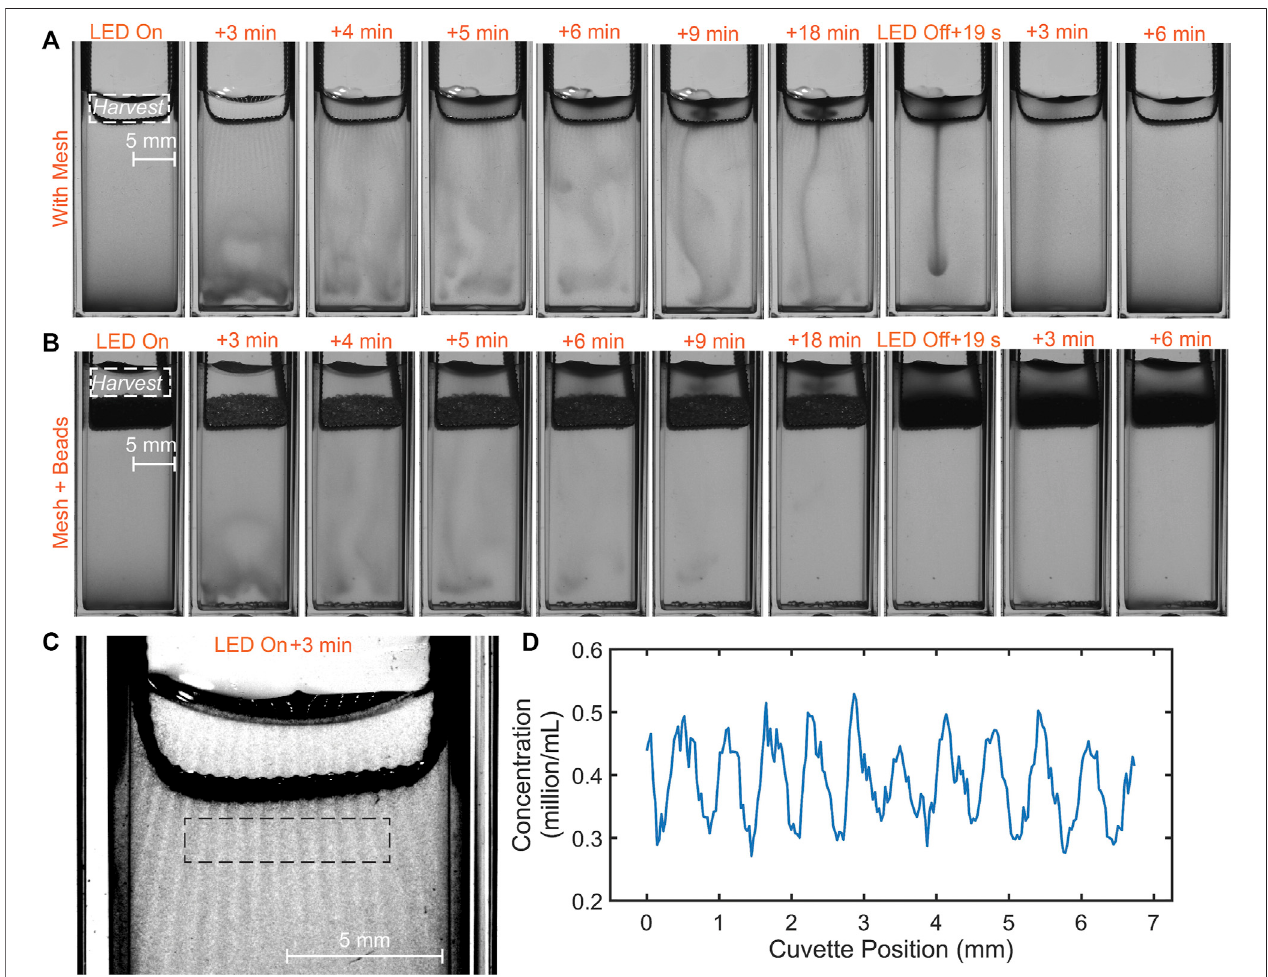
FIGURE 4 | Microalgal suspension dynamics for the case of: (A) a mesh; (B) mesh + beads (400 mg) placed at the top of the suspension. The dynamics is similar, but thereare importantdifferences. Signi fi cantlya cloud-like plume iscompletelytrapped between theporouslayer and top surface, while in thecase ofthe mesh, itcan leakasathinplumetothesuspensionbelow. (C) Phototactic “ curtain ” patternformedbytheaccumulationofcellsinresponsetothelightandshadowpatterngenerated byilluminationfallingonthemesh. (D) Curveshowingtheconcentrationofalgaeacrossthephototacticcurtains(meanfeaturewidth (cid:2) 630 ± 53 μ m)markedin (C) .